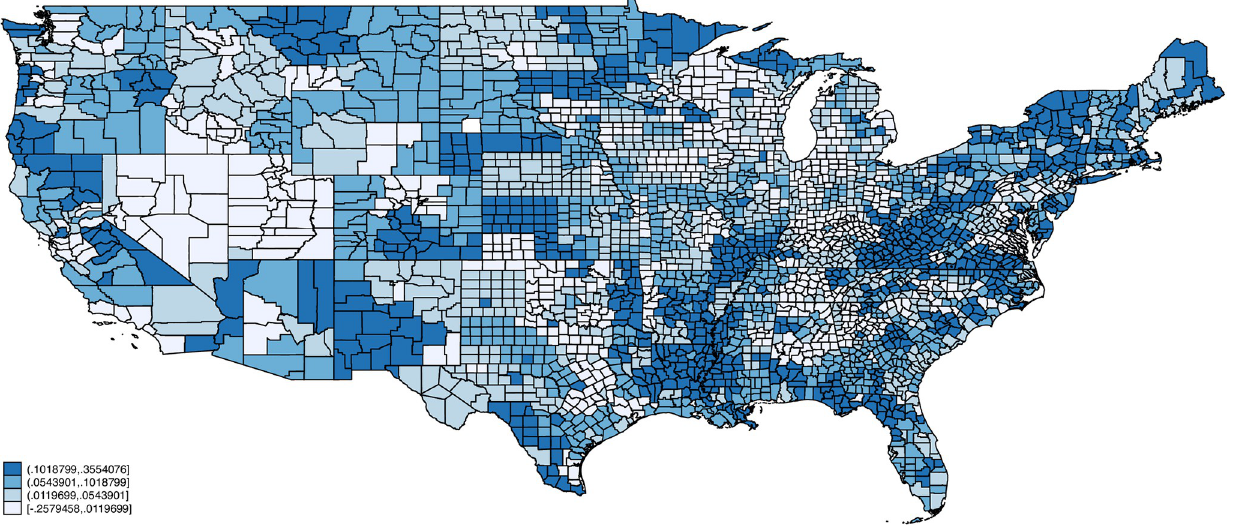
Fig 2. Exposure to infection/disease by county. Notes: Each county is assigned the average value of the exposure index based on the distribution of employment across occupations using 2018 American Community Survey (ACS) data. Endpoints correspond to quartiles. Person weights from the ACS are